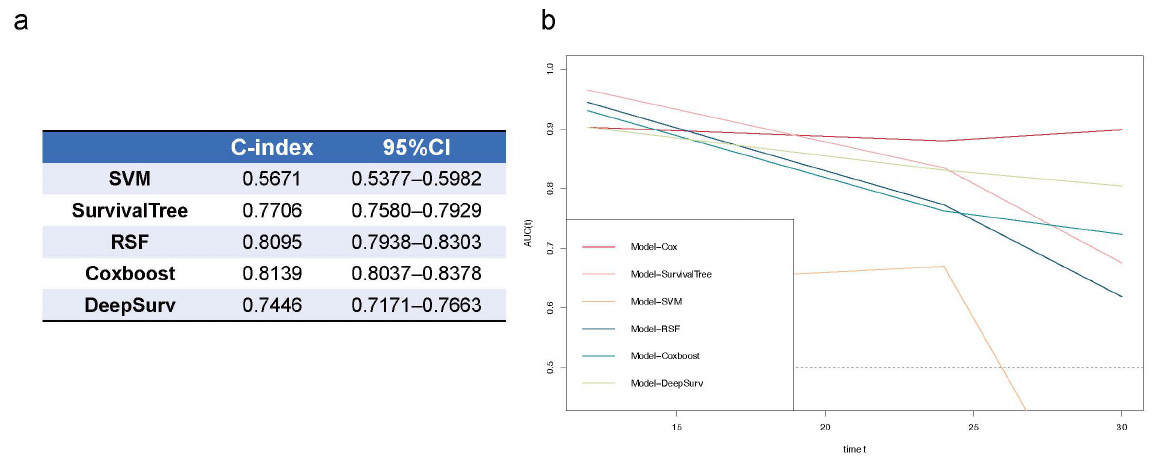
Figure 6. Comparison of survival prediction models for CKD prognosis using Cox regression, machine learning, and deep learning. ( a ) C-index of machine learning models by SVM, SurvivalTree, RSF, Coxboost, and deep learning model of DeepSurv; ( b ) time-dependent ROCs of all prediction models. SVM, support vector machine; RSF, random survival forest; 95%CI, 95% confidence